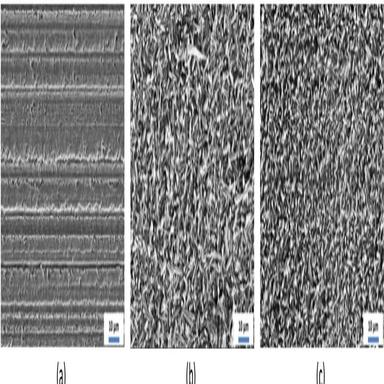
SEM images showing the surface morphology of (a) finished-machined, (b) white-machined, and (c) green-machined samples.